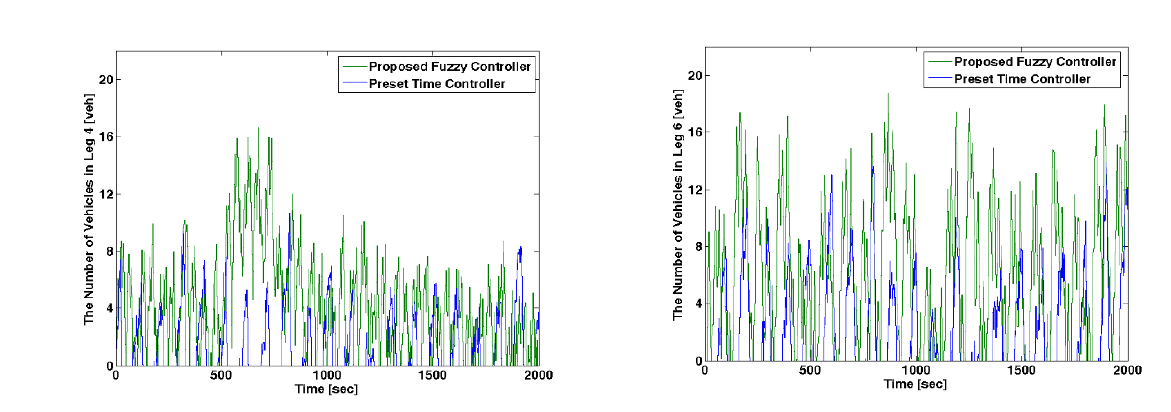
Figure 14. The number of vehicles in Leg4